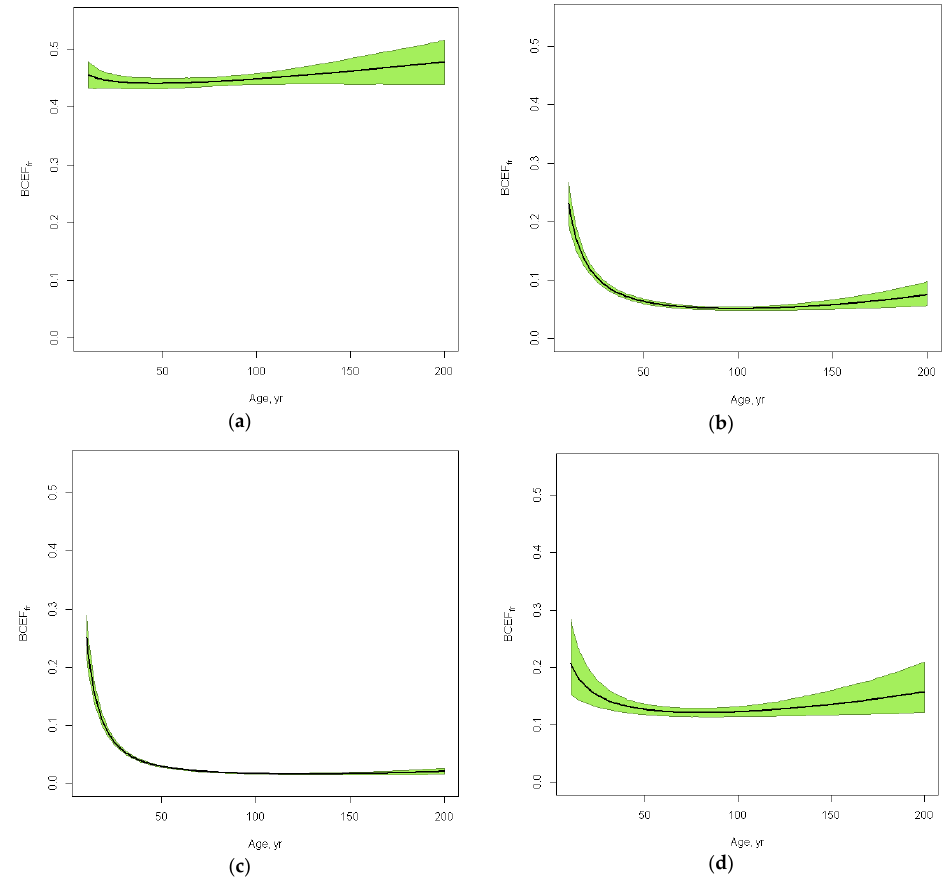
Figure 1. Estimated biomass conversion and expansion factors ( BCEFs ) with confidence envelops for ( a ) stem, ( b ) branches, ( c ) foliage and ( d ) roots in European Russia southern taiga pine forests depending on the stand age with a fixed SI = 21 m and RS = 0.7. In order to build the regression models, we have used 1000 sample plots for stem biomass, 983—for branches, 1038—for foliage and 308—for roots. Forests 2017 , 8 , x FOR PEER REVIEW